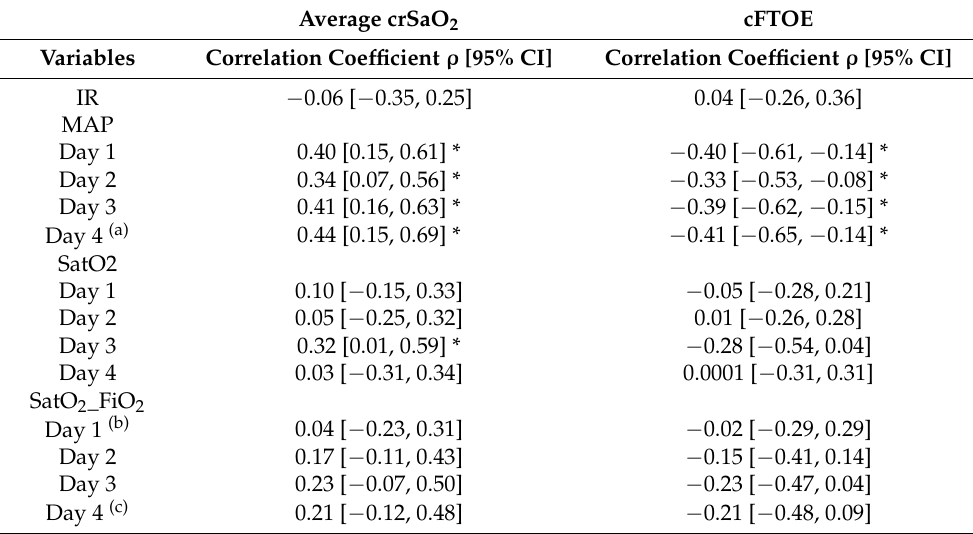
Table 3. Bivariate correlation analysis between cFTOE and crSaO 2 with IR, TAM, tcSaO 2 and tcSaO 2 _FiO 2.